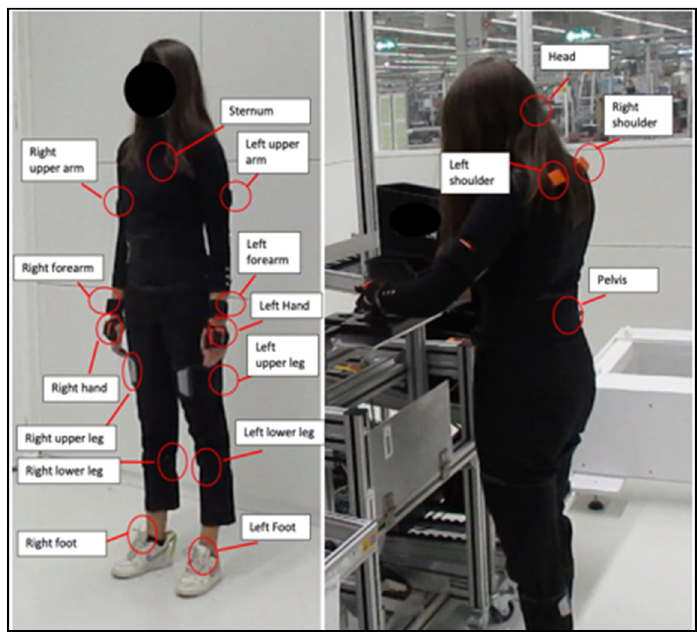
Figure 7. Sensors’ placement on the body.